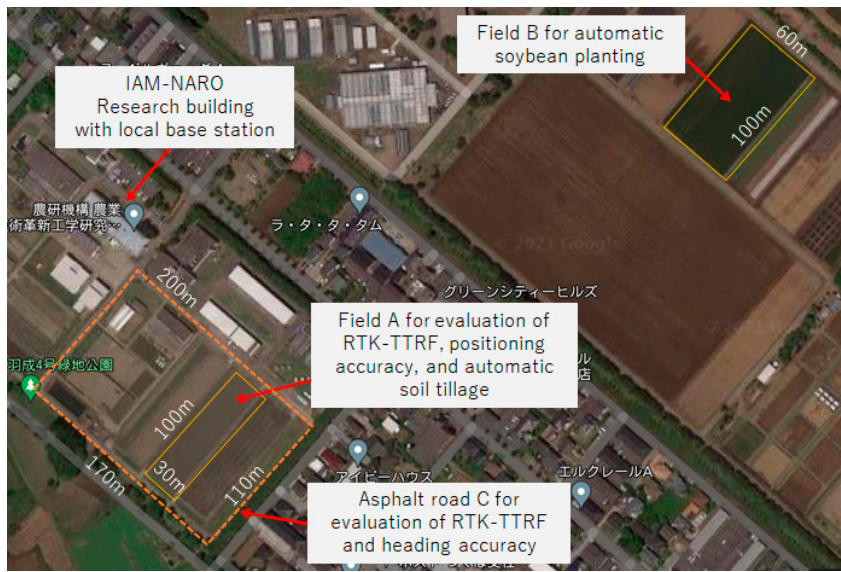
Figure 2. Testing site for dynamic evaluation of GNSS devices.